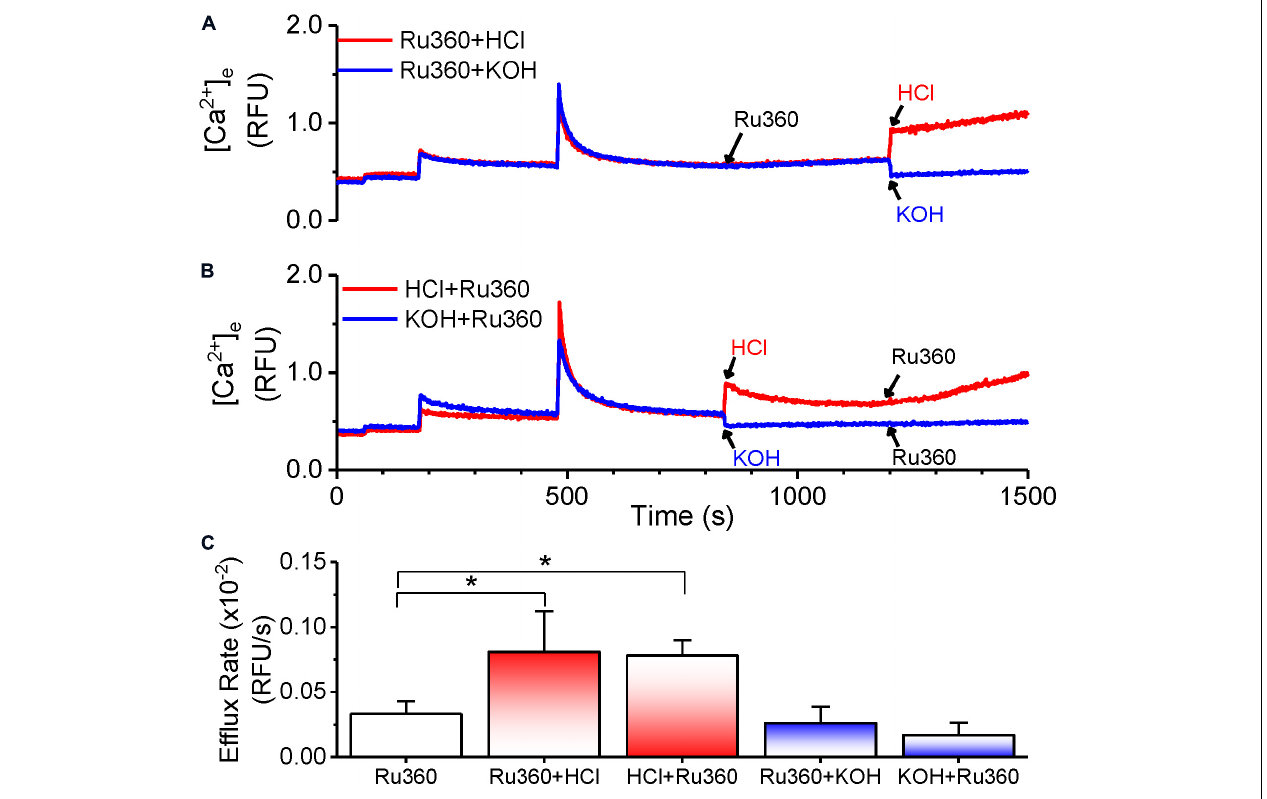
FIGURE 6 | pH-dependent modulation of Ca 2 + -efflux rate. (A,B) Representative raw traces of extra-matrix Ca 2 + measured as relative fluorescence intensity changes in Na + -free experimental buffer loaded with the Ca 2 + -sensitive ratiometric dye Fura-4F. 20 µ M CaCl 2 pulses were given at 180 and 480 s and allowed to reach steady state before applying different treatments as follows: (A) Addition of 1 µ M Ru360 at 840 s followed by HCl (pH = 6.85 ± 0.05, red trace) or KOH (pH = 7.55 ± 0.05) at 1200 s (B) Addition of HCl (pH = 6.85 ± 0.05, red trace) or KOH (pH = 7.55 ± 0.05) at 840 s followed by 1 µ M Ru360 at 1200